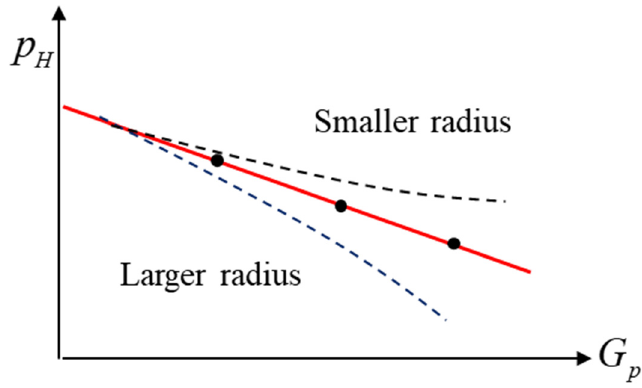
Figure 11. Validation results by the material balance equation.